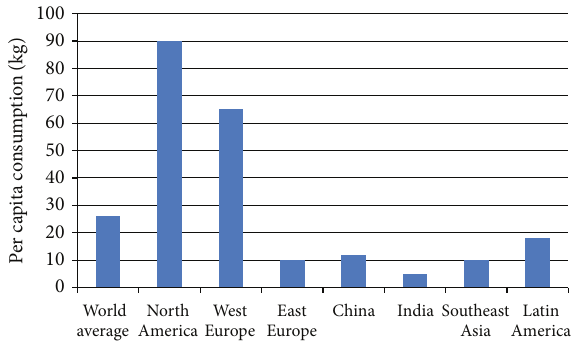
Figure 1: Global per capita consumption of plastics [2].